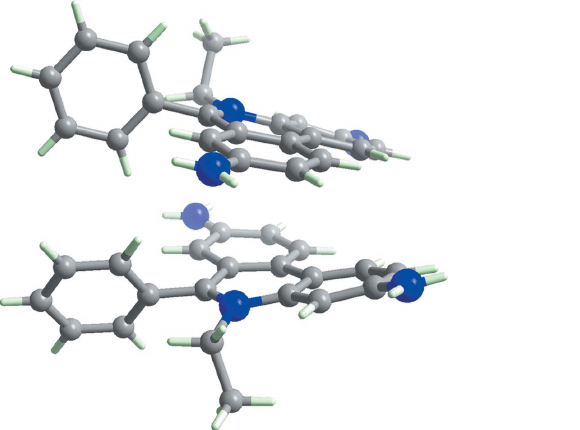
Figure 3 Illustration of the packing of the title compound along the a axis.